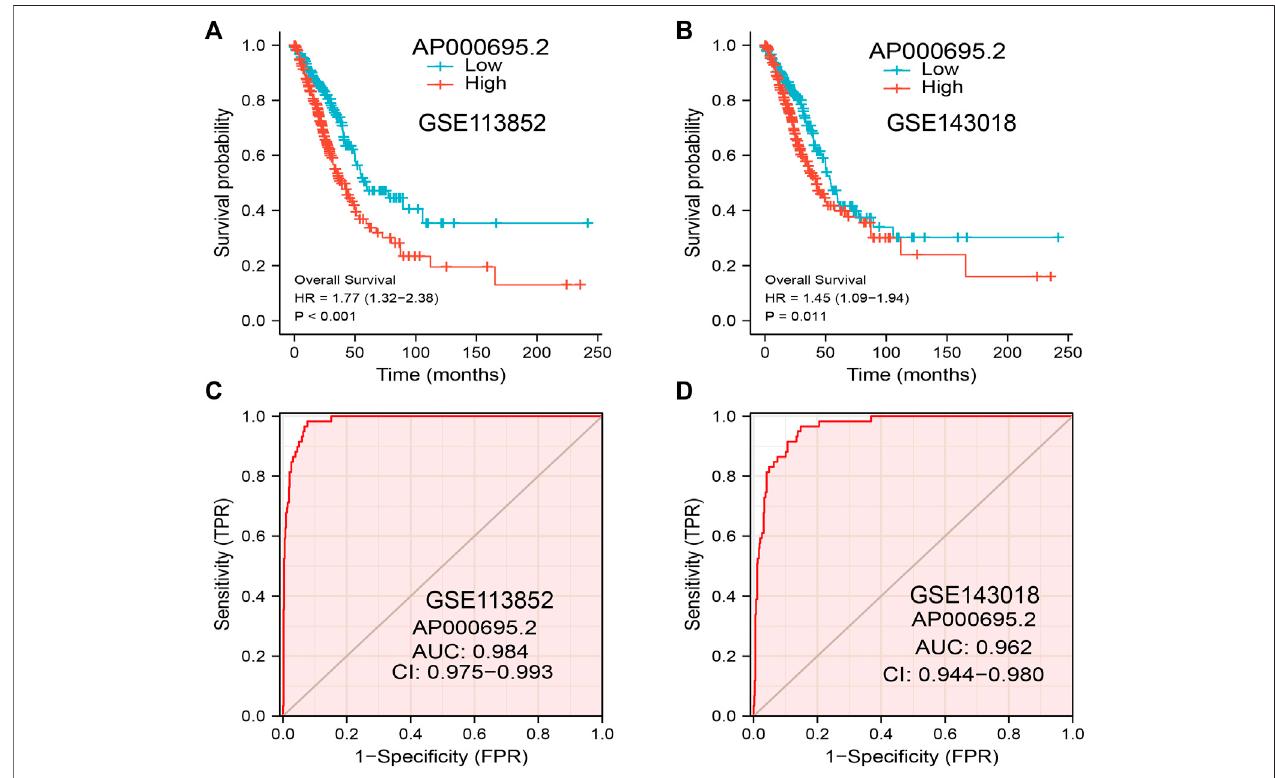
FIGURE4| PredictivepowersfortheprognosisofAP000695.2inLUADpatients. (A – B) Kaplan – MeiersurvivalvalidationoftheprognosticvaluesofAP000695.2in LUAD patients based on the GEO cohorts. (C – D) ROC curves show the AUC of AP000695.2 for predicting the overall survival of LUAD